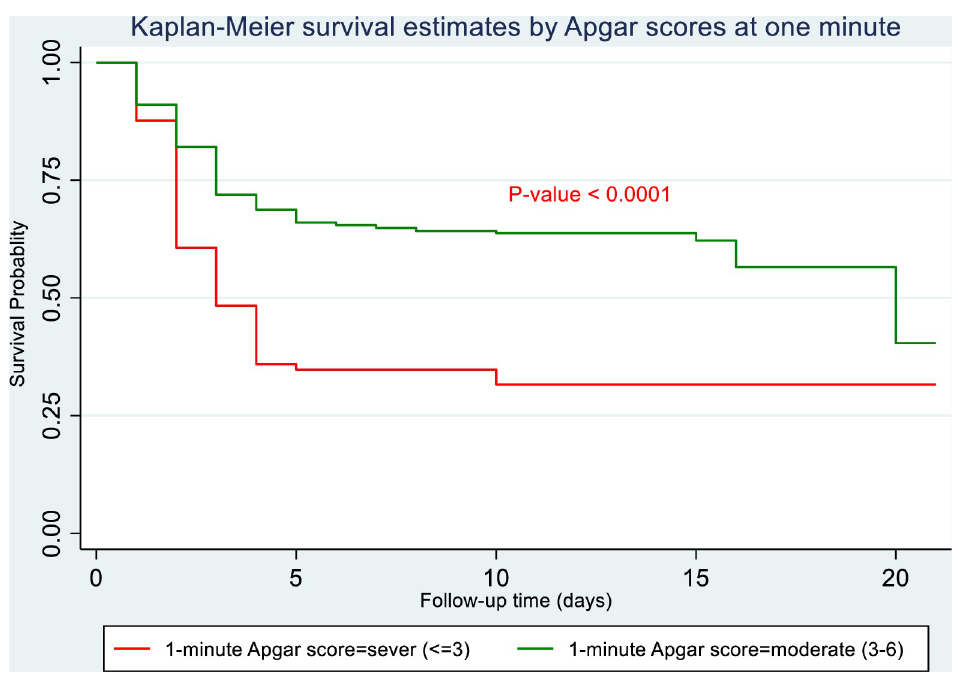
Fig 5. Kaplan-Meier survival curve of newborns with asphyxia in Northwest Ethiopia selected hospitals from November 1, 2018, to November 1, 2019, by 1-minute Apgar score.